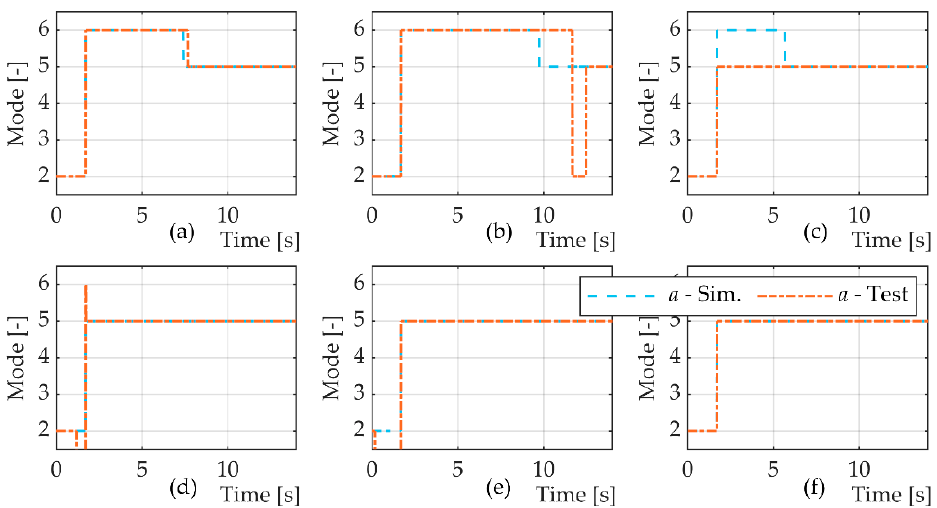
Figure 14. All test cases, 𝑝 (cid:3013)(cid:3020),(cid:2869) = 100 bar: ( a ) 40 kg; ( b ) 80 kg; ( c ) 120 kg; ( d ) 160 kg; ( e ) 200 kg; ( f ) 240 kg.